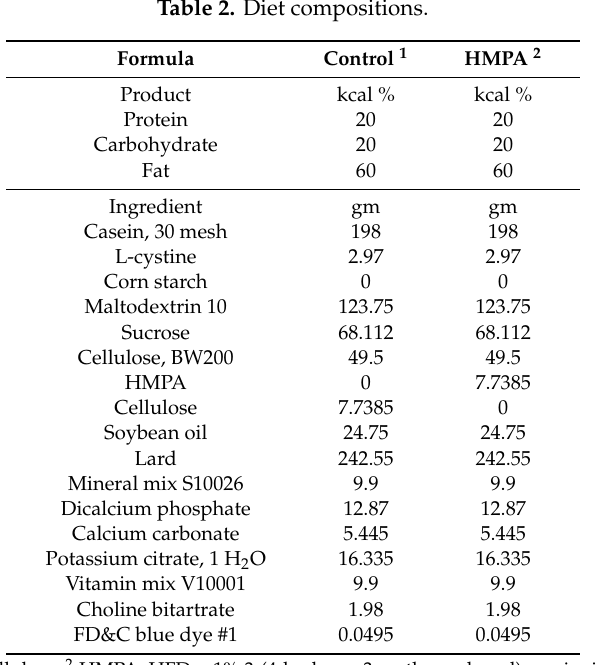
#1: synthetic organic compound primarily used as a blue colorant for dietary